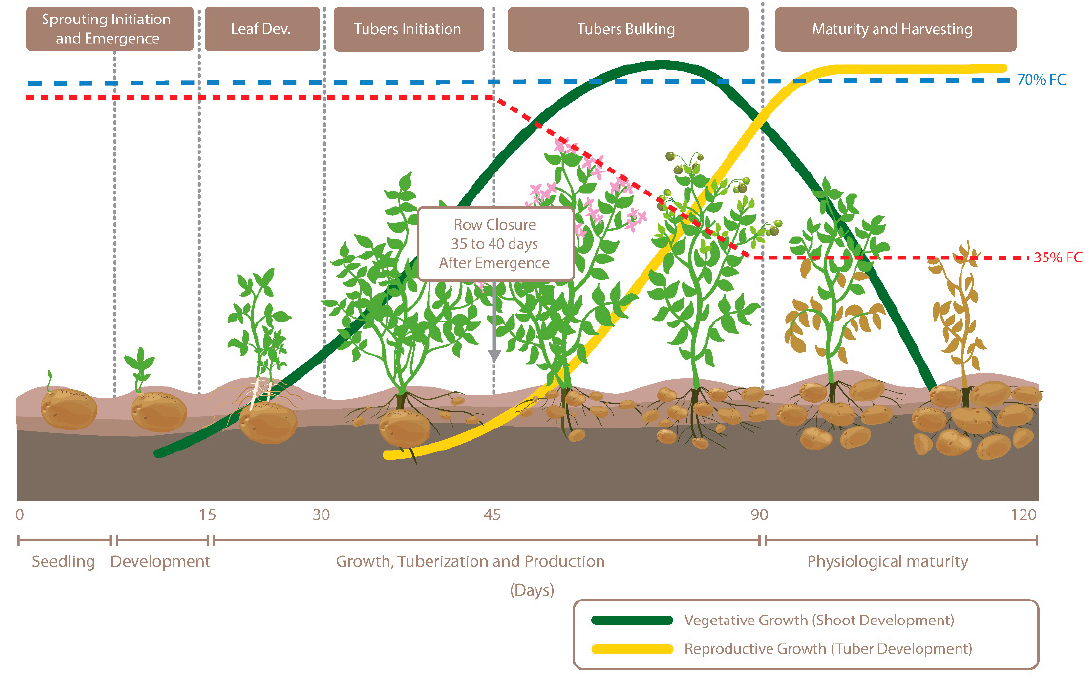
Figure 1. Visualization of potato growth stages and in-season soil moisture trends when soil moisture was maintained at 35% and 70% field capacity